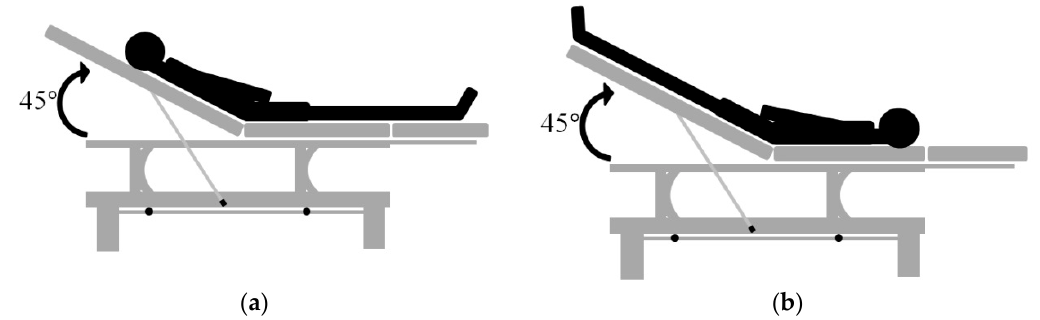
Figure 3. The schematic diagram of passive leg raising PLR test: ( a ) The seating posture of subject before PLR test and ( b ) the lying posture of subject under PLR test.